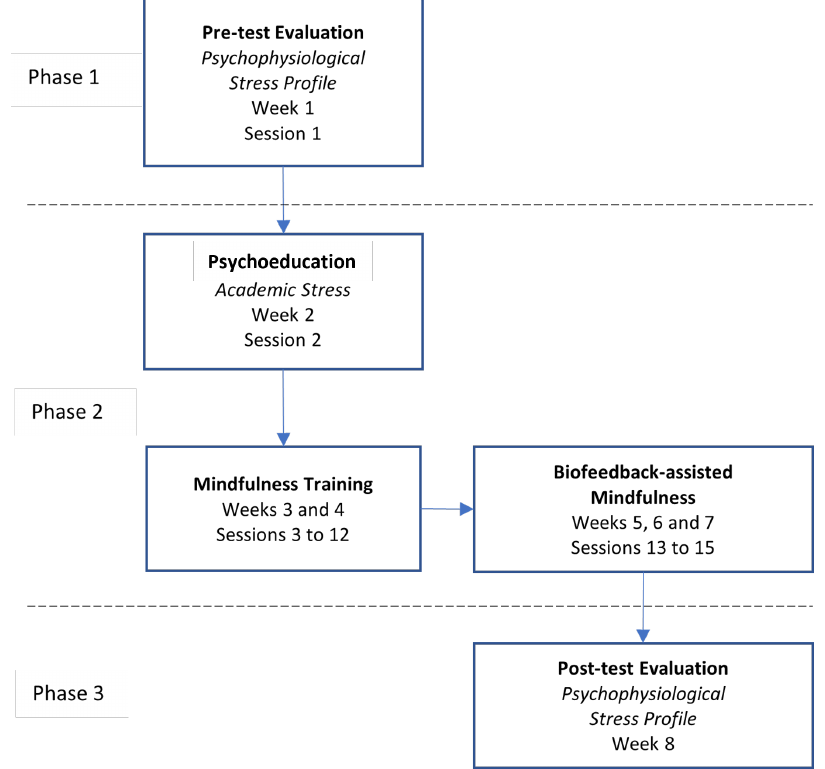
Figure 3. Diagram showcasing the multicomponent program and data collection